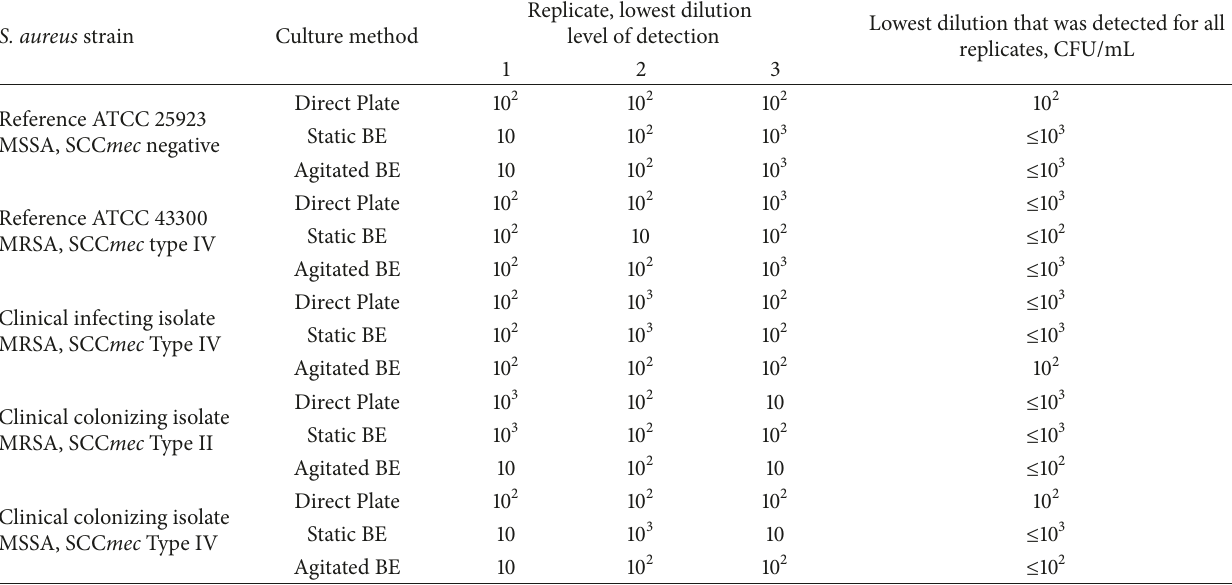
Table 1: Recovery of Staphylococcus aureus by culture